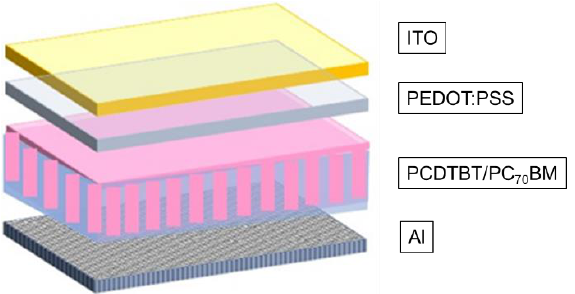
Figure 3. Diagram of PV concept with optimized nanostructure architecture to minimize the pathway of the charge carriers.